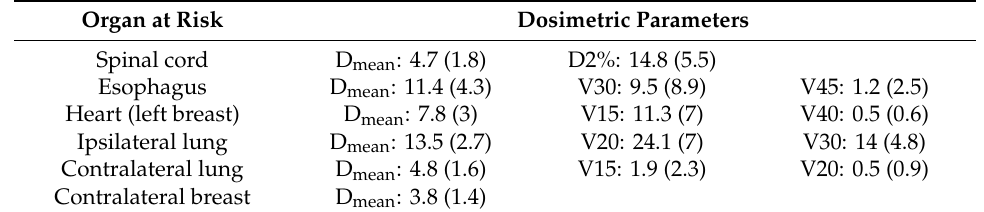
Table 3. Doses delivered to organs at